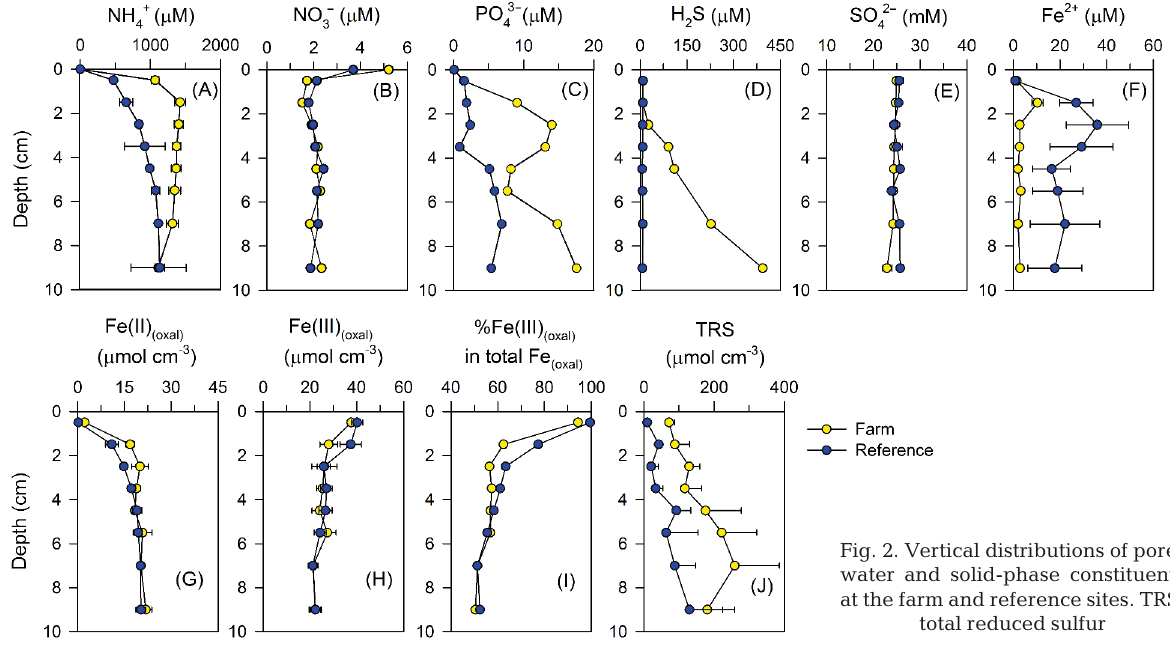
Fig. 2. Vertical distributions of pore- water and solid-phase